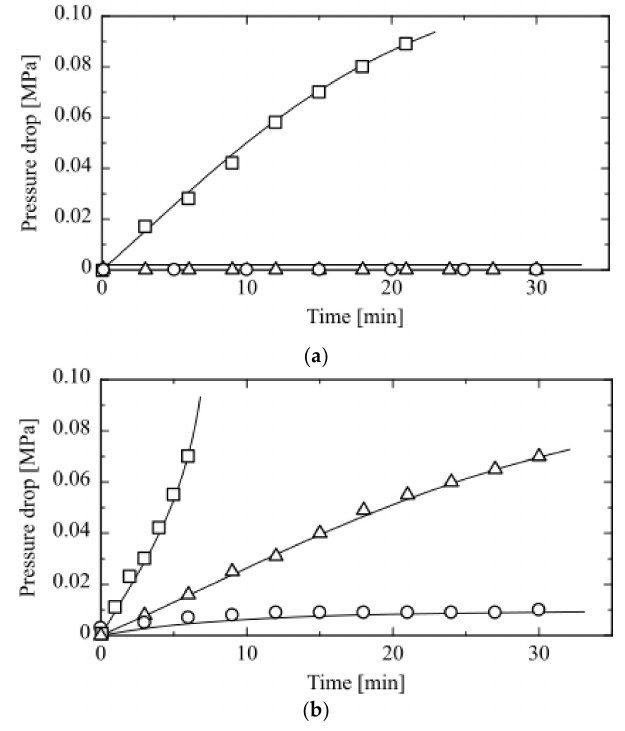
Figure 3. Time dependence of the pressure drop during permeation of water through ( a ) Mag gel-packed column and ( b ) gel-packed column. Circles: 10 mL / h, triangles: 25 mL / h, squares: 50 mL / h. The initial height of the Mag gel layer was set to 1.0